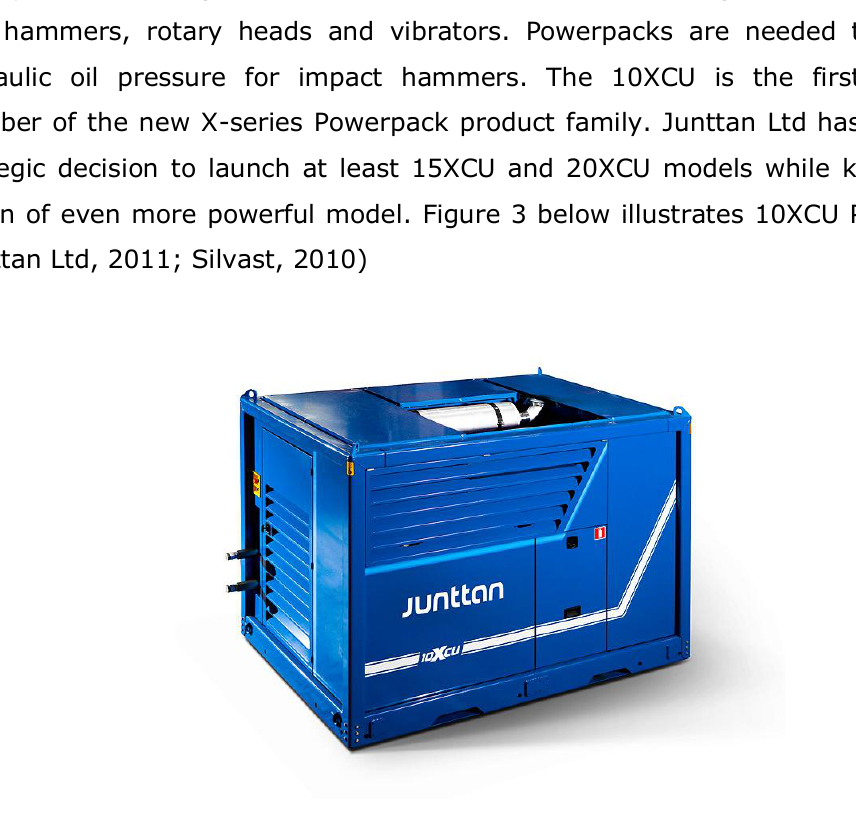
Figure 3. The 10XCU Powerpack (Junttan Ltd,